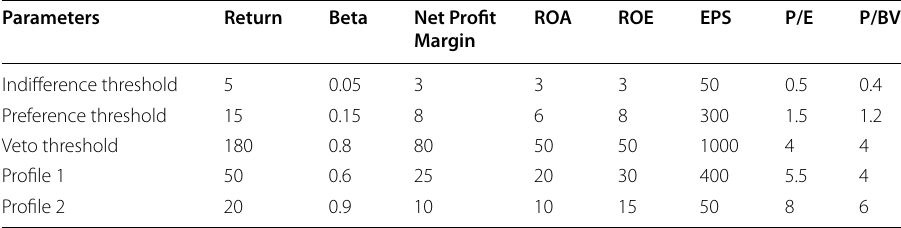
Table 6 Parameters of ELECTRE-TRI and FlowSort